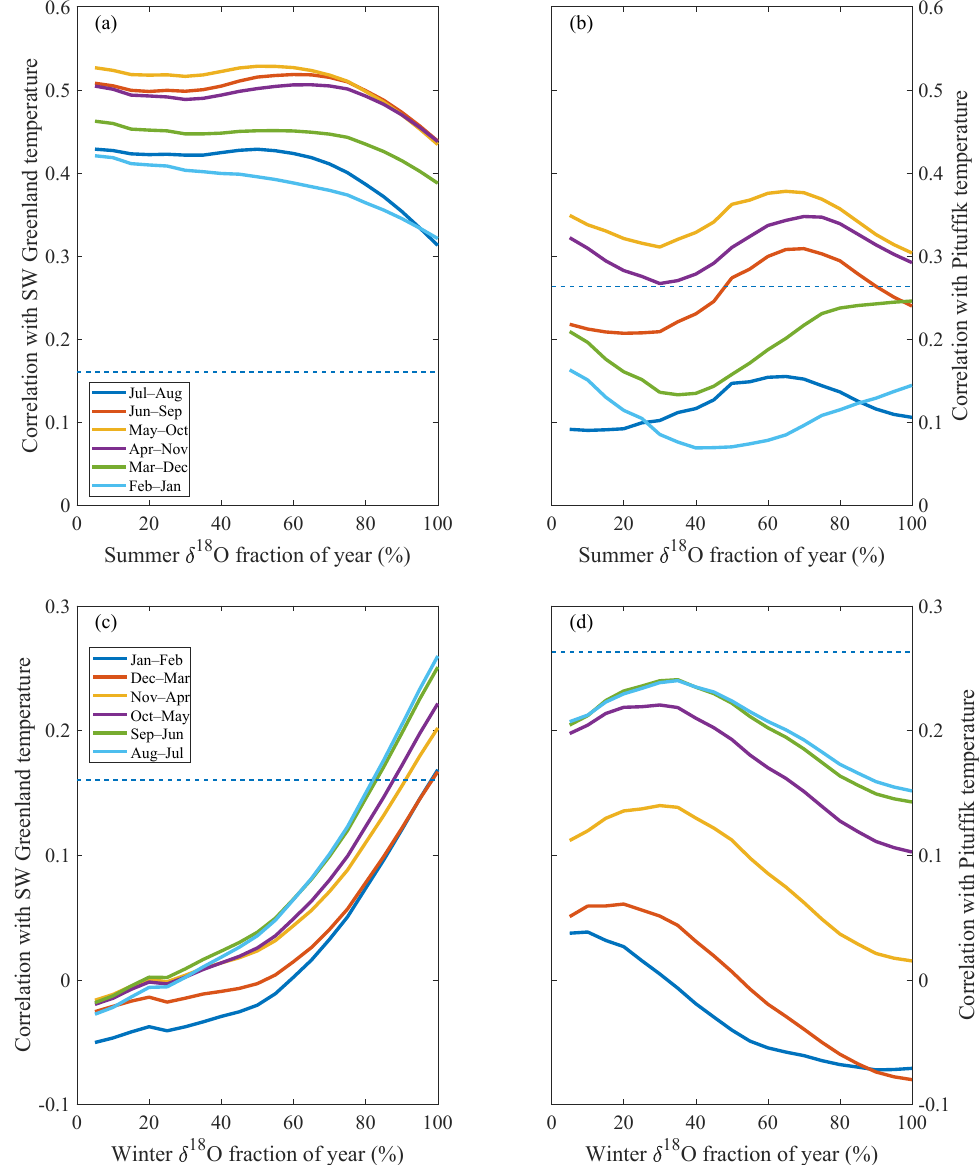
Figure 2. Correlation coefficients between stacked data of seasonal δ 18 O and SW Greenland (a, c) and Pituffik (b, d) measurement temper- ature records depending on variously defined choices of seasonal δ 18 O data. The analysis covers 1855–2004 for the SW Greenland record and the period 1949–2004 for the Pituffik record. The 95% confidence level is marked as dashed line ( t test).